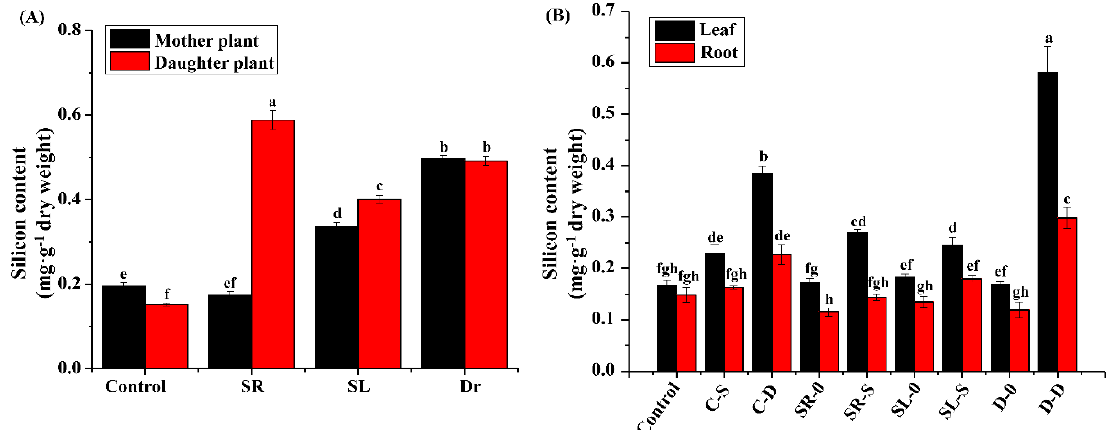
Figure 2. The Si content in different tissues of strawberry plants after being treated with Si. ( A ), Si content in leaves of mother or daughter plants before cutting propagation; ( B ), Si content in leaves or roots after cutting propagation. Lowercase letters indicate significant differences calculated by Duncan’s multiple range test at p ≤ 0.05. Vertical bars indicate the standard error ( n = 3). The letters before the hyphen indicate Si being applied before the cutting propagation, while the letters after the hyphen represent Si being supplied after the cutting propagation. C, control; SR, spraying the runners; SL, spraying the leaves; Dr, drenching the roots; D, drenching the roots; 0, spraying distilled water; S, spraying the leaves.